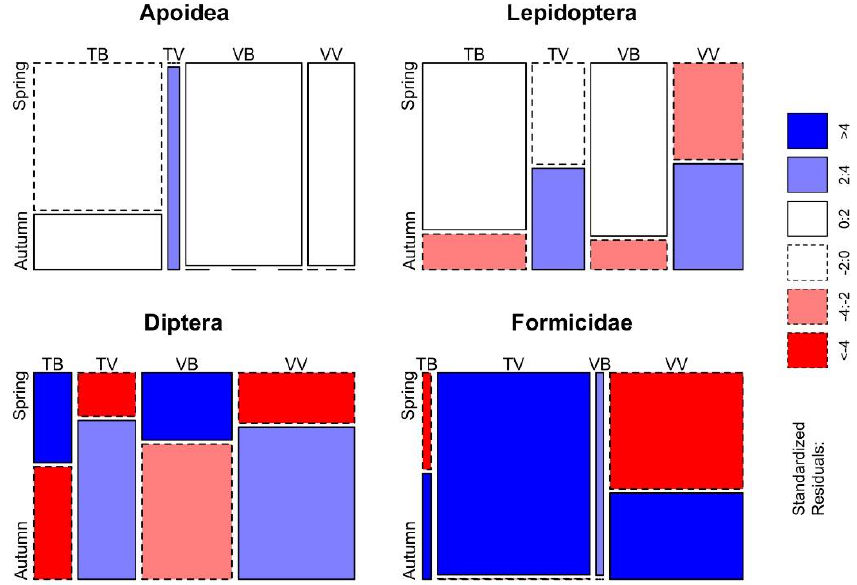
Figure 6. Mosaic plot of the differences between trap–bait combinations per season for Apoidea, Lepidoptera, Diptera and Formicidae. Cells representing negative residuals are drawn in shades of red and with broken borders while positive ones are drawn in blue with solid borders.